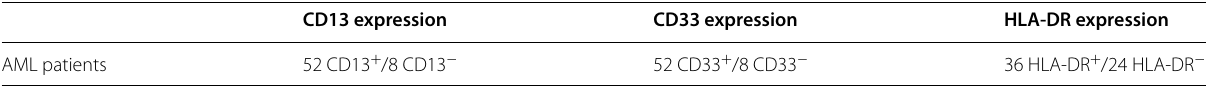
Table 2 CD13, CD33 and HLA‑DR expression in AML patients